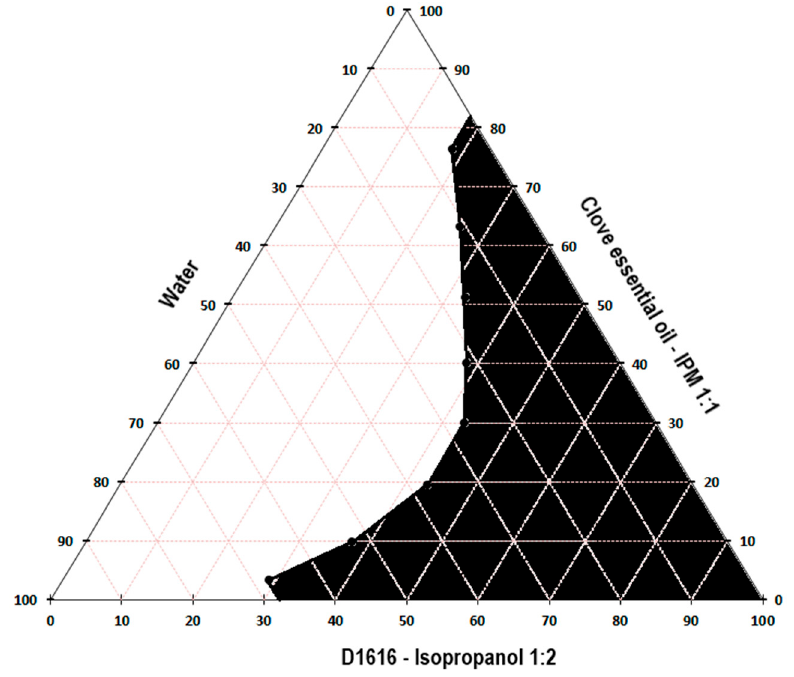
Figure 2. Pseudo-ternary phase diagram for the clove essential oil/IPM– D1616/IPA –water system, for S mix ratio 1:2.